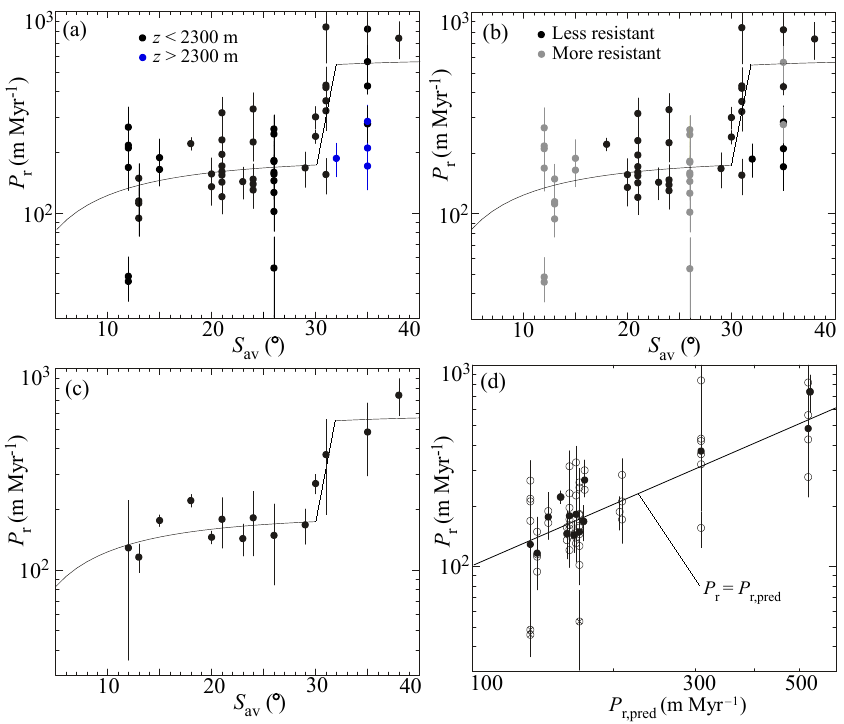
Figure 2. Plots of P r and their relationship to average slope, S av , and other potential controlling factors. (a) Plot of P r values versus S av . Data points colored blue are from the highest elevations of the range ( z >2300m). The piece-wise curve plots Eq. (4), with the three segments of the curve corresponding to the three conditions in the equation. (b) The same plot as panel (a) , except that data points are colored according to whether they are from rocks that are relatively more resistant (gray) or less resistant (black) to weathering. (c) Plot of P r values averaged for each value of S av . In panels (a) and (b) , error bars represent the uncertainty of each data point, while in panel (c) the error bar represents the standard deviation of the data points averaged for each S av value. (d) Plot of P r versus values predicted from Eq. (5). Unfilled circles show individual data points, while filled circles represent the averaged data plotted in panel (c)